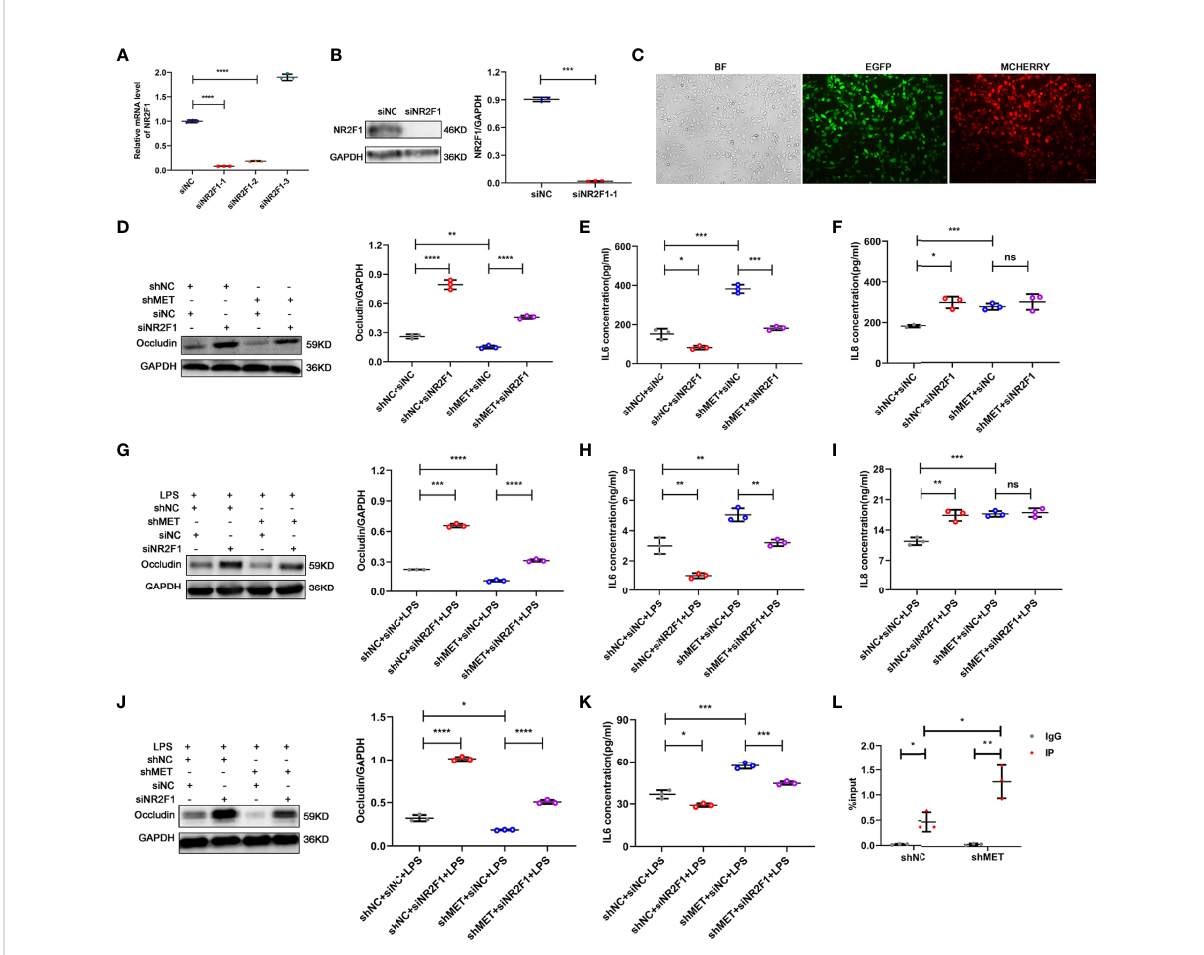
FIGURE 5 Silencing NR2F1 increased expression of Occludin and inhibited secretion of IL-6. (A) Fold changes of NR2F1 mRNA after silencing (mean ± SD; **** P<0.0001; n=3/group; one-way ANOVA). (B) Silencing ef fi ciency of NR2F1 using siNR2F1-1. Left, representative western blotting images of NR2F1. Right, quanti fi cation of relative expression of NR2F1 (mean ± SD; *** P<0.001; n=3/group; unpaired Student ’ s t-test). (C) Cotransfection of METTL3- and NR2F1-silenced lentivirus (BF, bright fi eld; EGFP, enhanced green fl uorescence protein; MCHERRY, red fl uorescence protein; scale bar, 10 m m). (D) Protein level of Occludin after METTL3 and NR2F1 silencing in ARPE19 cells. Left, representative western blotting images of Occludin. Right, quanti fi cation of relative expression of Occludin (mean ± SD; ** P<0.01, **** P<0.0001;